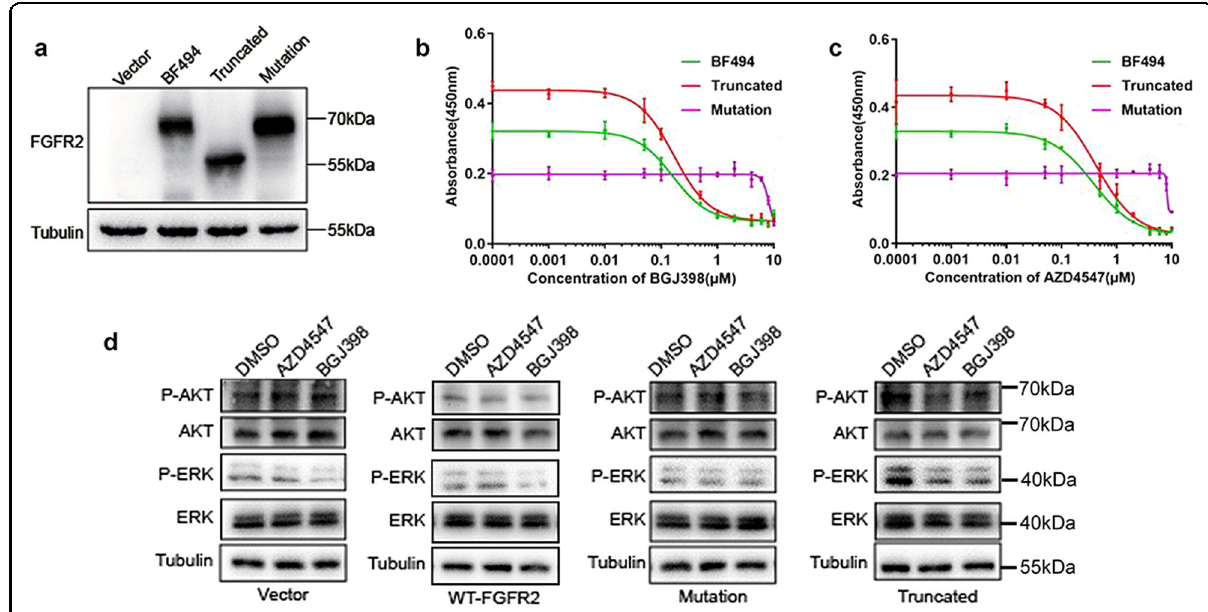
Fig. 7 Response of RBE cells expressing BF494 variations to FGFR2 -selective SMKIs BGJ398 and AZD4547. The expression of BF494, BF494- truncated, and BF494-mutation chimeras was detected by western blot with anti-Flag antibody ( a ). Dose-response curves for BGJ398 ( b ) and AZD4547 ( c ) in RBE cells expressing different BF494 variations. Western blotting showing phosphorylation of AKT and ERK in RBE cells expressing WT- FGFR2, BF494 truncation, BF494 mutation, or vector control ( d